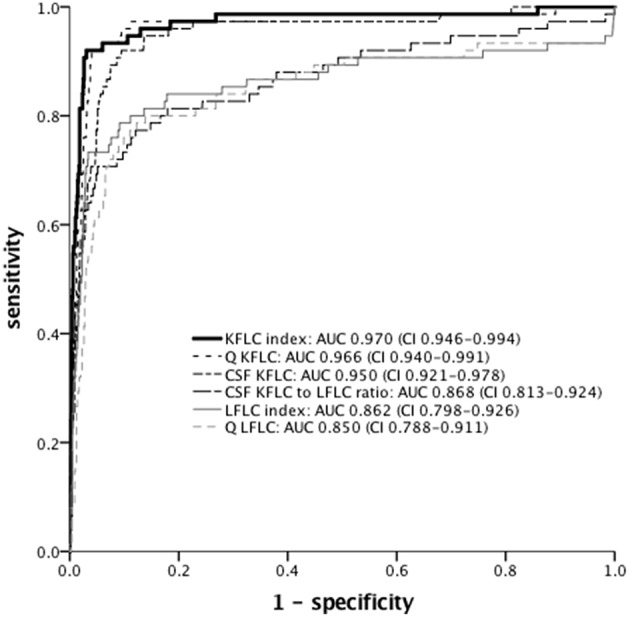
ROC curves of different FLC measures for discrimination between MS (n = 75) and non-MS (n = 1,149) patients. AUC and 95% confidence interval are given. KFLC, immunoglobulin kappa free light chain; LFLC, immunoglobulin lambda free light chain; Q Alb, CSF-serum ratio of albumin; Q KFLC, CSF-serum ratio of KFLC; Q LFLC, CSF-serum ratio of LFLC; KFLC index (Q KFLC/Q Alb); LFLC index (Q LFLC/Q Alb); ROC, receiver operating characteristics; AUC, area under the curve.